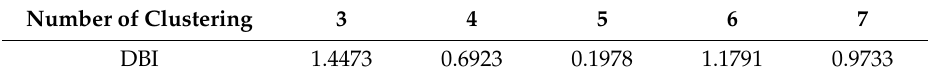
Table 1. The clustering result of field-collected wind turbine data. DBI: Davies Bouldin